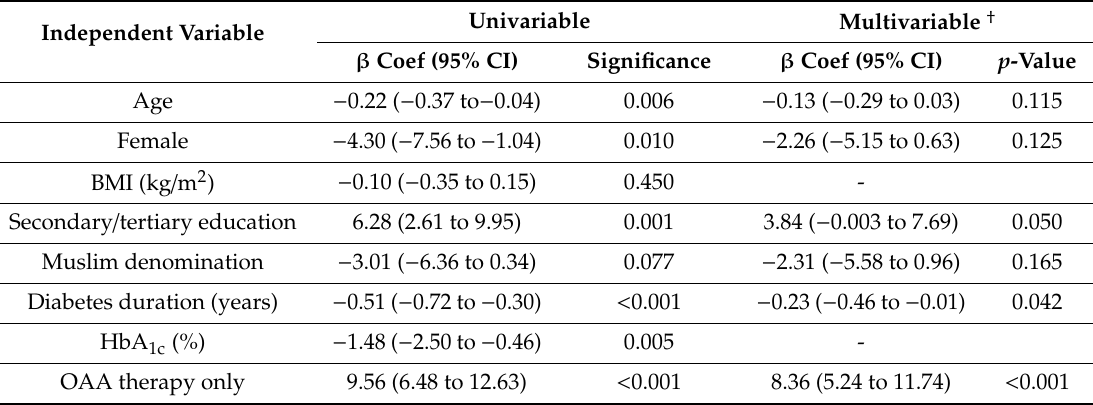
Table 3. Univariable and multivariable linear regression assessment of the impact of study variables on the percentage of the total adherence